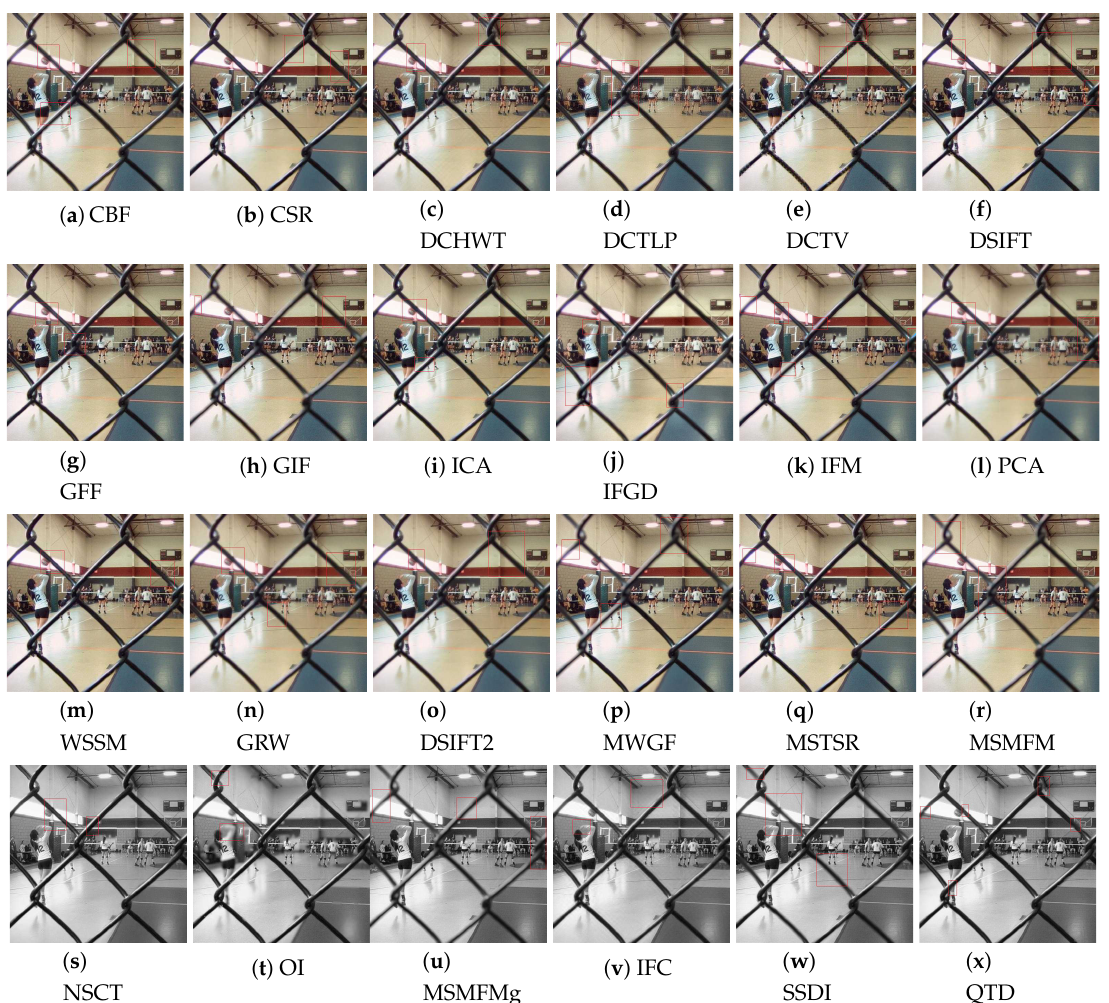
Figure 5. Visual comparison compared multi-focus image fusion methods on the fence image set of Lytro